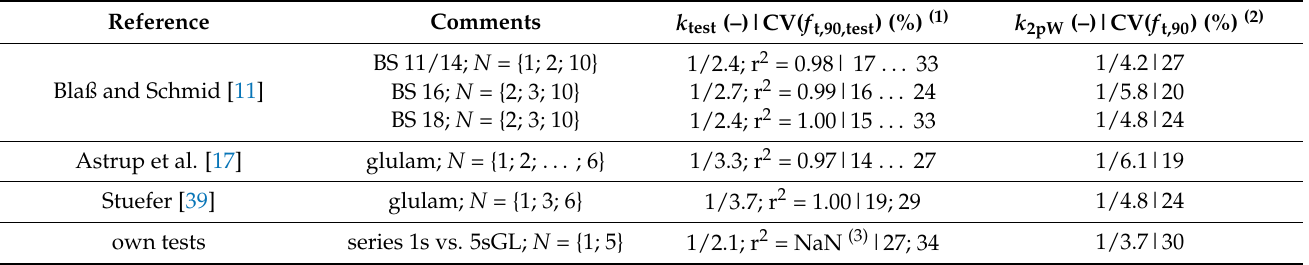
Table 11. Power coefficients from power regression analysis based on tests on glulam as well as for a two-parameter Weibull distribution